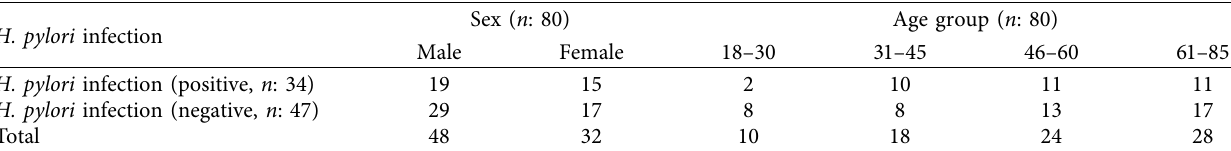
Table 5: The frequency of H. pylori infection among males and females in various age groups.